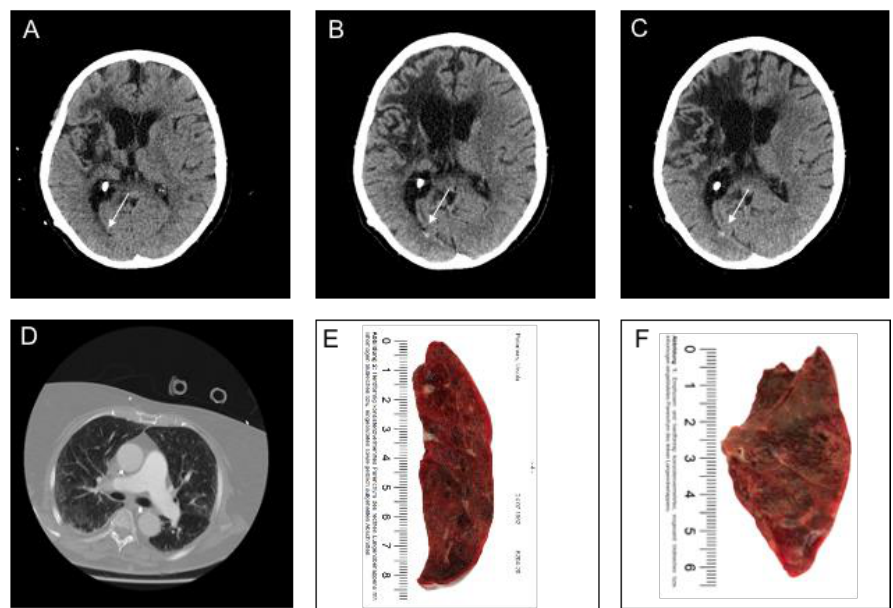
Figure 5. Representative computed tomography (CT) images of a patient with Coronavirus Disease 2019 with an intraventricular hemorrhage (IVH). Legend: ( A , D ): Brain CT image ( A ) with corresponding chest CT image at admission ( D ). ( B , C ): Brain CT image eight days ( B ) and ten days after hospitalization ( C ). ( F ): Longitudinal section of the right lung indicative of purulent, hemorrhagic pneumonia in the upper lobe. ( E , F ): Longitudinal section of the left lung indicative of purulent, hemorrhagic pneumonia and emphysematous structural alterations in the upper lobe. White arrow indicates acute intraventricular hemorrhage.